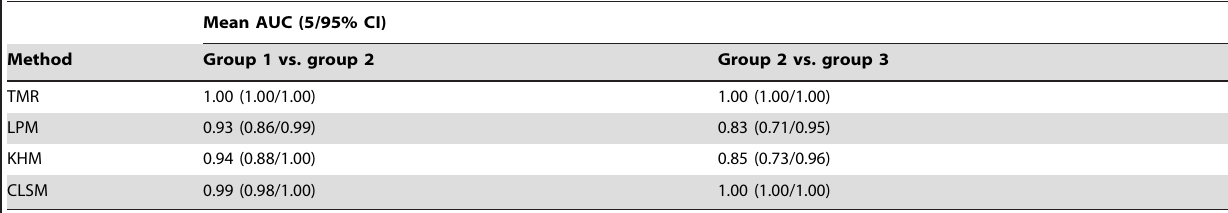
Table 3. ROC curve